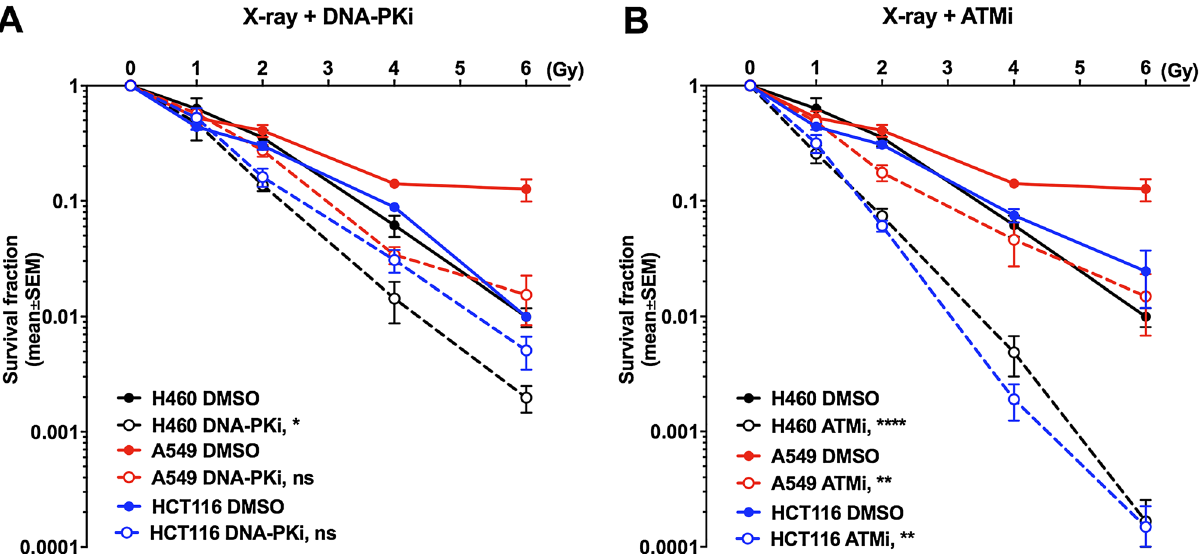
Figure 2. DDR inhibitors sensitized cancer cells to α-radiation. Clonogenic survival for DNA-PKi ( A ) or ATMi ( B ). H460, A459, HCT116 and HEK293 cells were treated with 200 nM DNA-PKi and ATMi for 2 h prior to α-radiation, giving doses of 4, 8, 16 Gy, then incubated for 24 h and reseeded for colony formation. Statistical analysis: mean ± SEM, n ≥ 2, 2way ANOVA, Tukey’s multiple comparisons test, (*) p < 0.05, (**) p <